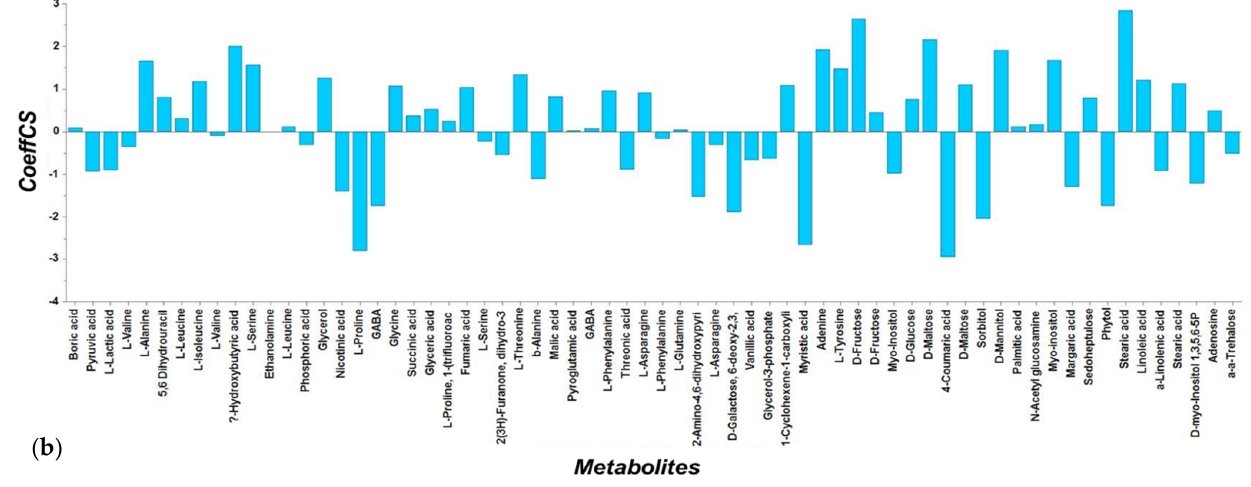
Figure 4. Orthogonal partial least squares-discriminant analysis (OPLS-DA) PC1/PC2 score plot for the GC/EI/MS metabolite profiles of N. tenuis- punctured tomato top, middle, and lower leaves, in comparison to the respective leaves of the untreated plants. The ellipse represents the Hotelling’s T 2 with 95% confidence interval. Six pooled samples were analyzed per treatment (Initial C; control or unpunctured plants, P; plants punctured by predator, A; top, B; middle, C; lower leaves) ( a,b ), and OPLS coefficient plot with values of scaled and centered PLS regression coefficients (Coeffs) for the selected Y variables for the whole dataset.